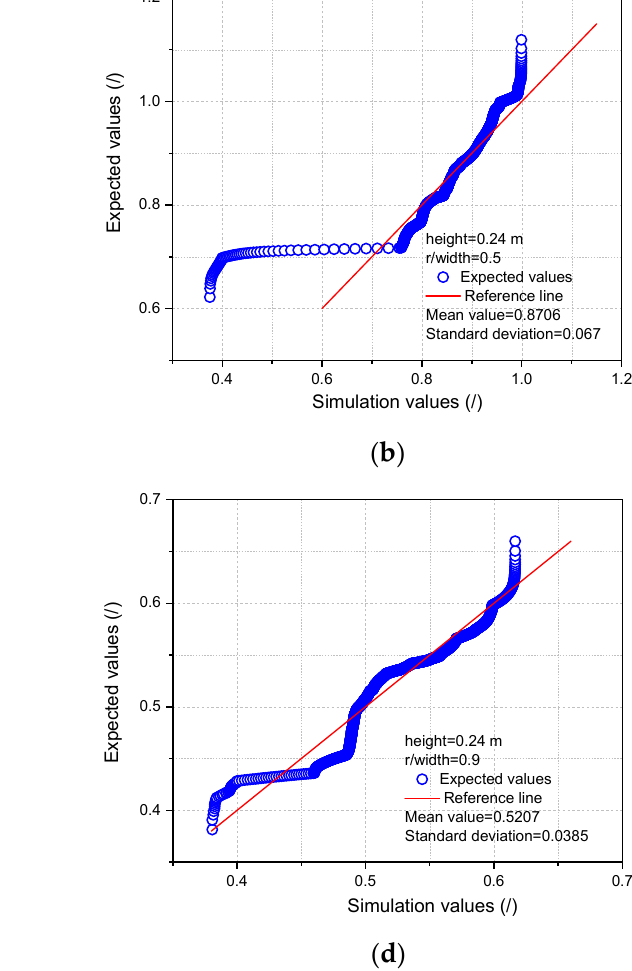
Figure 11. Quantile-quantile (Q-Q) plots of central and wall porosity of EG particles at the height of 0.24 m and 0.5 m, r/Width = 0.5 and 0.9, ρ p = 800 kg/m 3 . ( a ) central distribution, 0.5 m; ( b ) central distribution, 0.24 m; ( c ) wall distribution, 0.5 m; ( d ) wall distribution, 0.24 m. The power spectrum density (PSD) function transformed by the fast Fourier transform (FFT) algorithm is a type of a methodology to identify the single bubble, multiple bubbles in turbulent flows. Dominant frequency can be used to characterize the particle dispersions in gas–particle two-phase turbulent flow. Wide-band spectrums imply that more bubbles and narrow-band spectrums associated with sharp peak profiles denote a single bubble or slugging behaviors [72,73]. Figures 13 and 14 represent the power spectral density as a function of the porosity of EG and particles used in experiment at the height of 0.24 m and 0.5 m, r/Width = 0.5 and 0.9, ρ p = 800 kg/m 3 , and ρ p = 2700 kg/m 3 , respectively. For the EG particle at the height of 0.5 m, the dominant frequencies for the central and wall